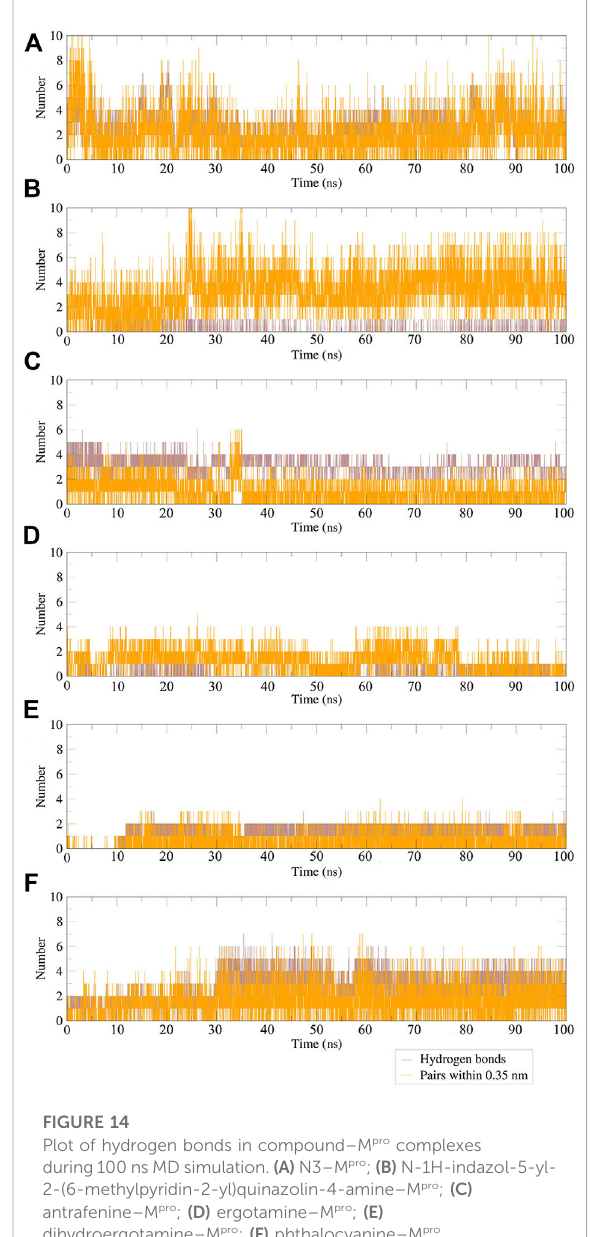
FIGURE 14 Plot of hydrogen bonds in compound – M pro complexes during 100 ns MD simulation. (A) N3 – M pro ; (B) N-1H-indazol-5-yl- 2-(6-methylpyridin-2-yl)quinazolin-4-amine – M pro ; (C) antrafenine – M pro ; (D) ergotamine – M pro ; (E) dihydroergotamine – M pro ; (F) phthalocyanine – M pro